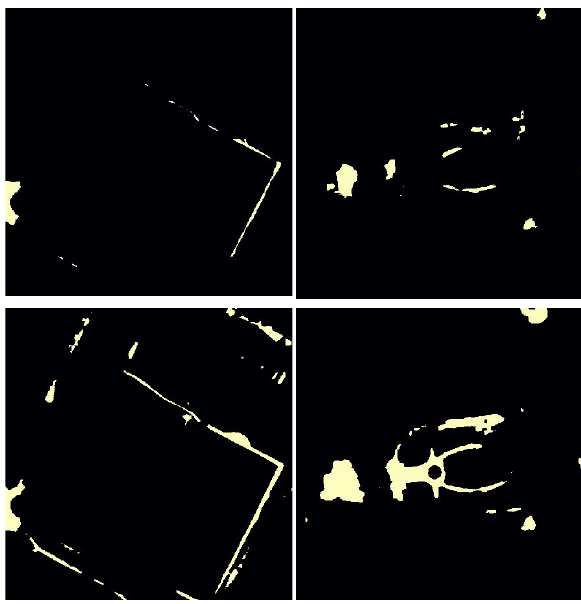
Figure 10. Comparison of BCE and WCE losses binarized predictions (top: RVB images, middle: BCE predictions and bottom: WCE predictions) for mineral materials and building